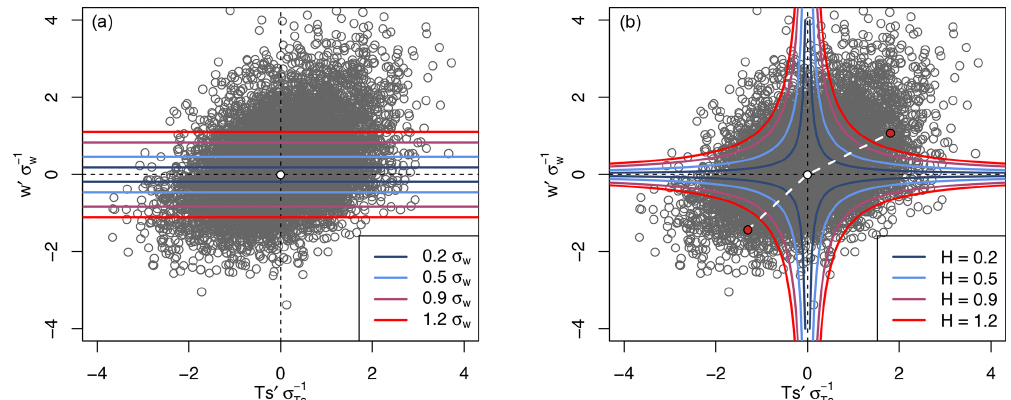
Figure 1. Schematic quadrant plots to visualize the application of linear (a) and hyperbolic (b) deadbands. Different colored lines show which data points are included for different deadband sizes. The white dot marks the origin in both panels. In the (b) , solid red dots mark the mean w (cid:48) /σ w and mean T (cid:48) s /σ T for up- and downdrafts when a hyperbolic deadband with H = 1 . 2 is applied (red). The dashed white lines in s (b) connect the red dots with the coordinate system origin. The deviation from 180 ◦ of the angle spanned between these lines is a measure for the asymmetry of the sample distribution.